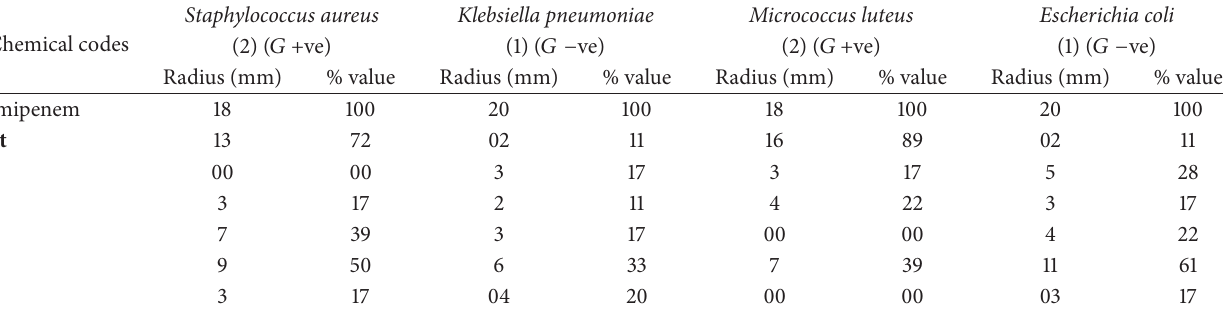
Table 2: Antibacterial activity of Ft and 1–5 .